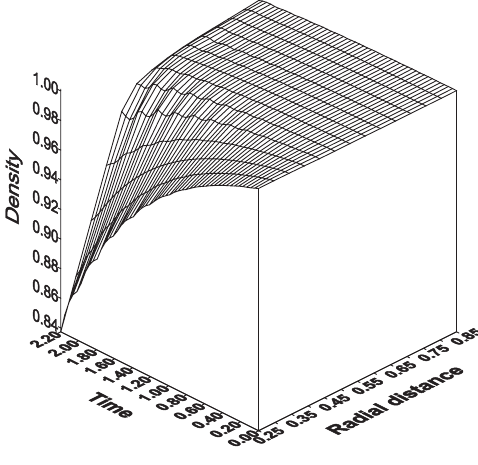
Figure 4.2 . Variation of the density with radial distance and